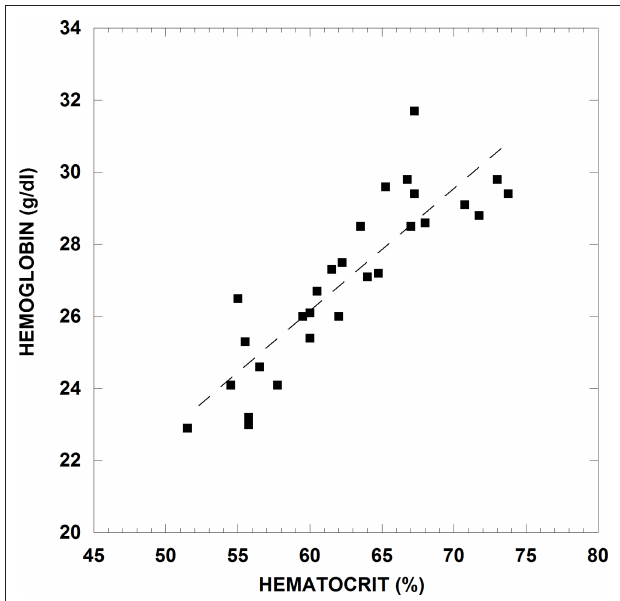
Figure 3 | Whole blood hemoglobin concentration versus hematocrit for blood from an adult Weddell seal during rest periods and after dives. Venous blood samples were taken from an indwelling catheter after the seal surfaced from a natural dive into heparinized Vacutainers © or syringes. An aliquot of whole blood was removed for spectrophotometric Hb analysis and the remaining blood immediately measured for Hct. This animal handling and sampling method has been well studied and documented for collecting diving recovery blood samples in Weddell seals (Kooyman et al., 1980; Qvist et al., 1986; Castellini et al.,